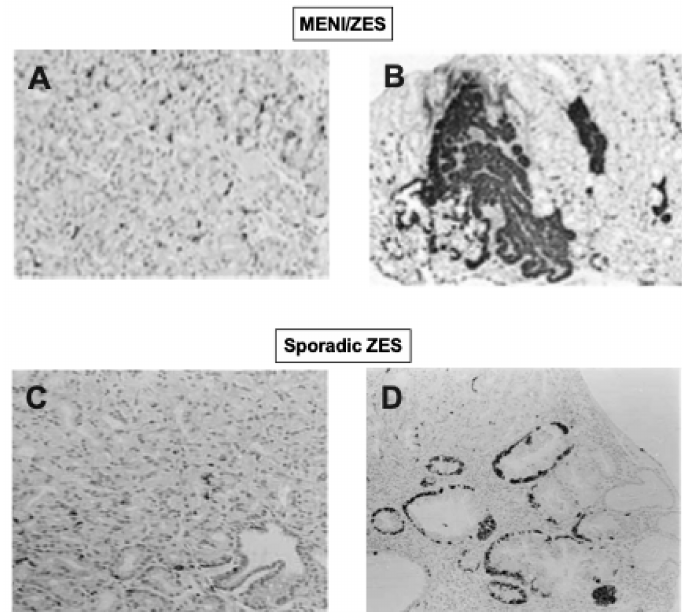
Figure 3. Examples of gastric ECL cell proliferative changes in ZES patients. In ( A ) and ( B ), results from gastric biopsies in two patients with MEN1/ZES are shown. In (A), a normal distribution of chromogranin A positive ECL cells in the oxyntic mucosa is shown. (B) shows a second MEN1/ZES patient a small intramucosal ECL-cell tumor (on the left), in association with an ECL-cell dysplastic lesion (in the center) and severe LH of ECl cells (on the right). In ( C ) and ( D ) are results from patients with sporadic ZES. (C) shows a normal ECL pattern with chromogranin staining and (D) shows micronodular and linear hyperplasia of ECL cells (in black) in a biopsy specimen of a patient with ECL cell dysplasia. Pictures are from Prof. C. Bordi (Univ. Parma) and made from data in [25,61]. Advanced ECL changes occurred in 53% of patients with MEN1/ZES with 2% showing dysplasia and 23% of patients have a gastric carcinoid found [61]. In sporadic ZES patients, 50% of patients had advanced ECL cell changes, 7% showed dysplasia, and none had a gastric carcinoid. The latter data show that advanced ECL changes including dysplasia can occur with prolonged chronic hypergastrinemia in man (mean duration of 13.2 yrs.) without any other contributing features such as the presence of MEN1, gastric mucosal atrophy, or gastric mucosal inflammation. 180X.